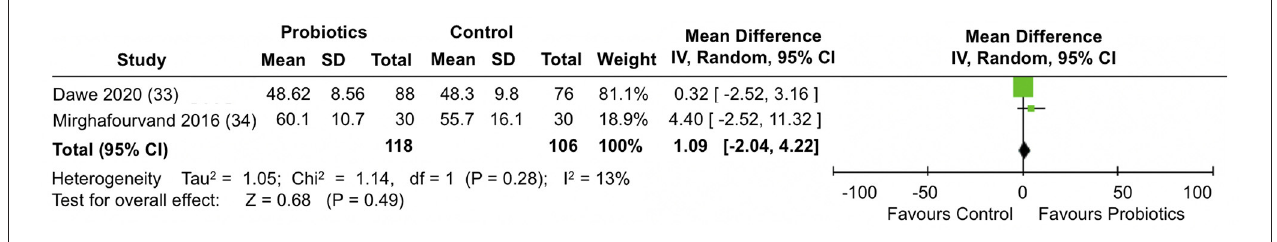
FIGURE 8 | Meta-analysis of the effect of probiotic supplementation on SF-36 mental health scores in the perinatal period.